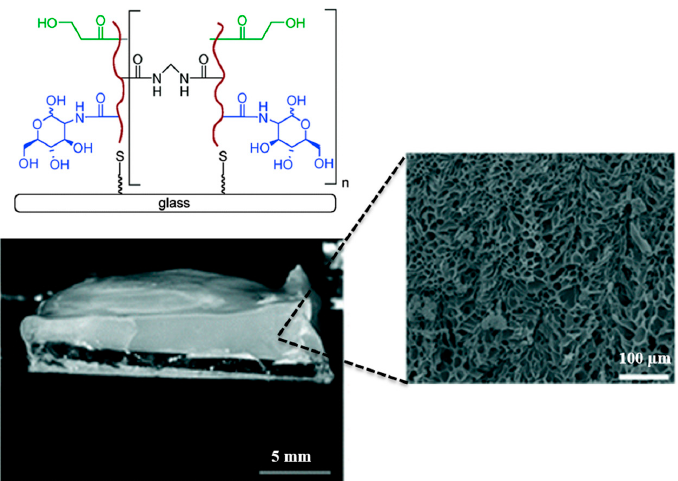
Figure 7. Glass-bound glycopolymer based hydrogels used as a model mucin network mimics in recreating the mucosal surface interfacial property. Scanning electron micrographs clearly shows highly porous structure of the hydrogels, these structures mimics membrane-bound mucin networks that were formed from glycoprotein chains. Reprinted with permission from Reference [201]. Copyright © 2015, The Royal Society of